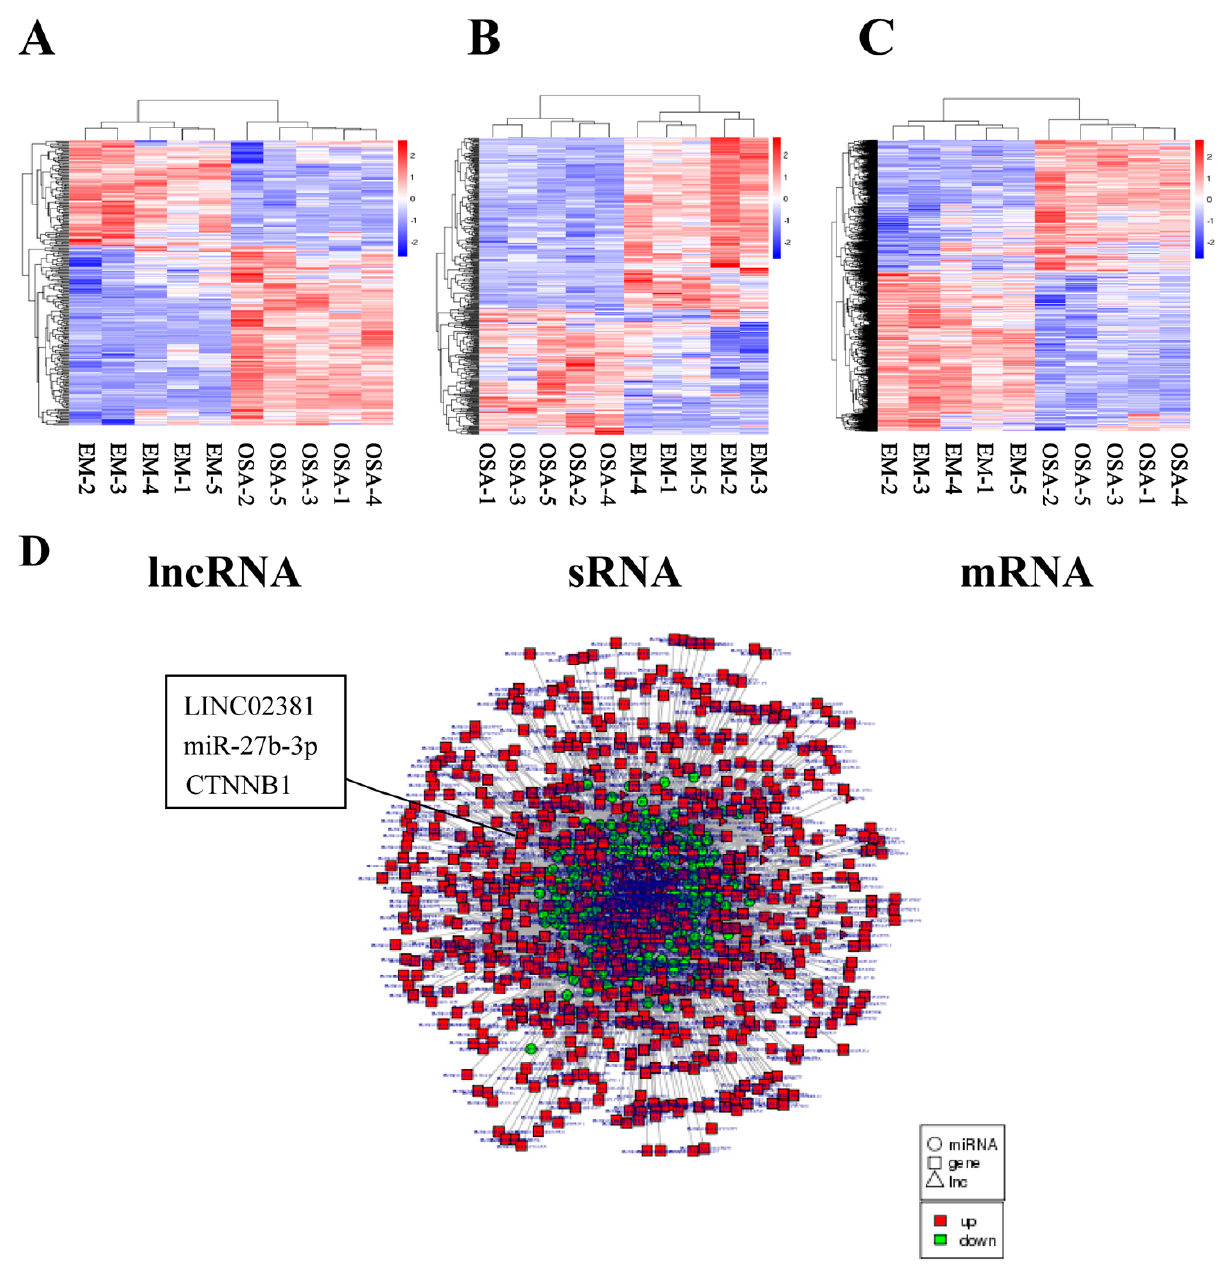
Figure 1. The lncRNA/miRNA/mRNA interaction network. Five pairs of ectopic endometrial tissue (OSA) and eutopic endometrial tissue (EM) samples from women with endometriosis were sent for whole-transcriptome sequencing. sRNA: small RNA. ( A – C ) Heatmap of the differentially expressed lncRNAs, sRNAs, and mRNAs. ( D ) The lncRNA/miRNA/mRNA regulatory interactions were formed according to the bioinformatics analysis.